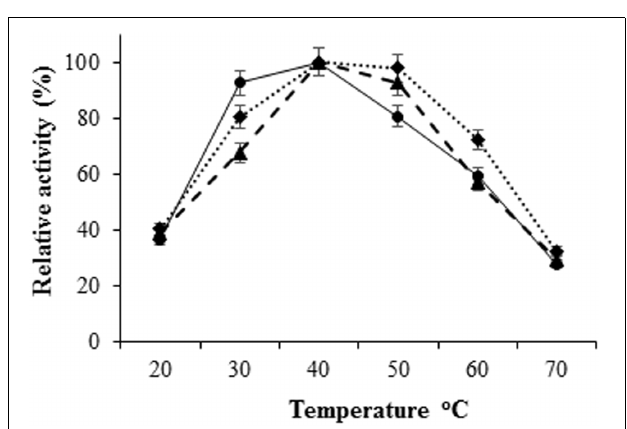
FIGURE 4 | Effect of temperature on activity of proteases from gut bacteria in H. armigera . The bacterial proteases were incubated with azocasein dissolved in 0.1 M glycine-NaOH buffer at different temperatures ranging from 20 to 70 ◦ C. Total proteolytic activity was measured at 450 nm. Effect of temperature on proteases from ( (cid:169) ) IVS1, ( • ) IVS2, and ( (cid:78) ) IVS3 isolates was determined. Each value represents the average of three